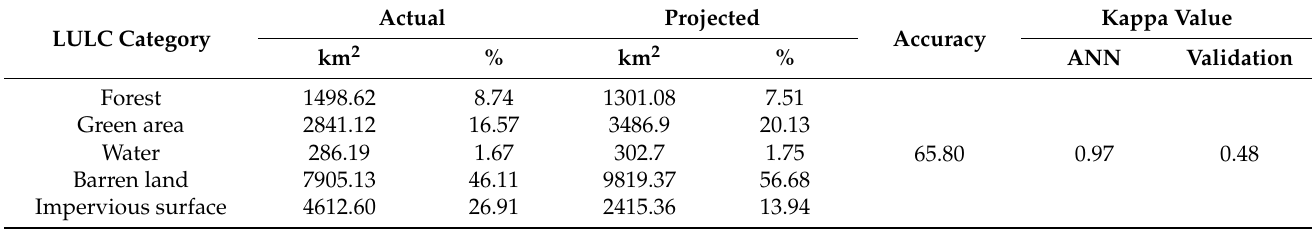
Figure 9. Actual and projected LULC 2020. Table 15. Actual and projected LULC of 2020.